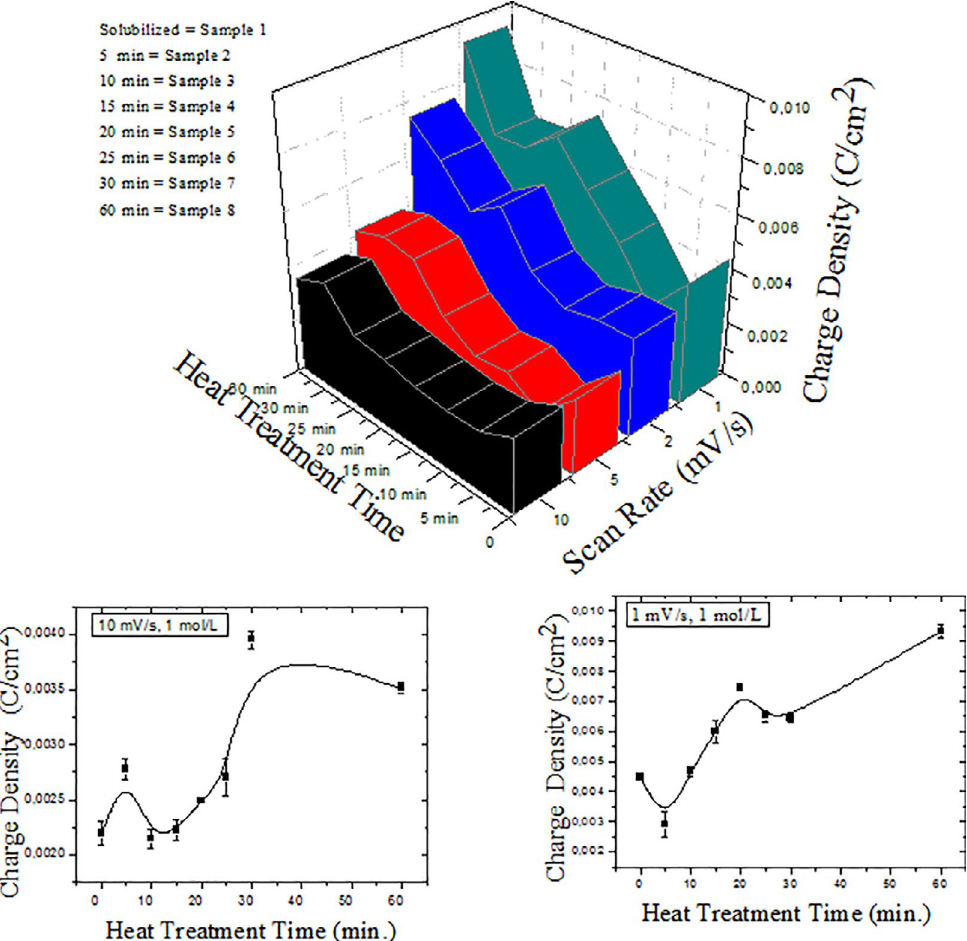
Figure 10. Scan rate effect on the charge density profile of the samples analyzed. a) Effect on the charge density profile for various scan rate. b) and c) For two scan rates b) 10 mV/s and c) 1 mV/